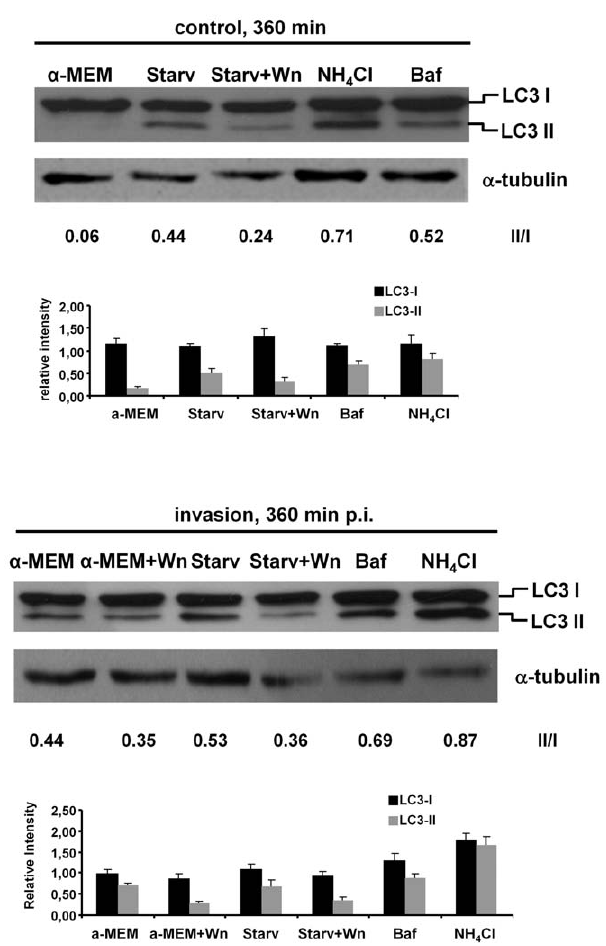
Figure 6. Analysis of LC3-I/LC3-II conversion. CHO-EGFP-LC3 cell monolayers subjected to the invasion assays as described in Figure 5 were harvested and resuspended in SDS-PAGE sample buffer. The samples were resolved by SDS-PAGE (30 m g of total protein was loaded per lane), transferred to nitrocellulose and detected with anti-GFP polyclonal antibodies (‘‘invasion’’, lower panel blots). Control, non- invaded CHO-EGFP-LC3 cells, that were subjected to the same treatments were also analyzed (‘‘control’’, upper panel blots). The positions of LC3-I and LC3-II bands are indicated. Protein loading was controlled according to the a -tubulin content (the blots detected with antibodies anti- a -tubulin are shown). Blots are representative of three independent experiments. The bands intensity was quantified with the ImageJ Programe, and the LC3II/LC3I (II/I) was calculated for the immunodetection experiment shown in the figure. The histogram represents the average 6 S.D. of the relative intensities of LC3-I or LC3-II versus a -tubulin of three independent experiments.